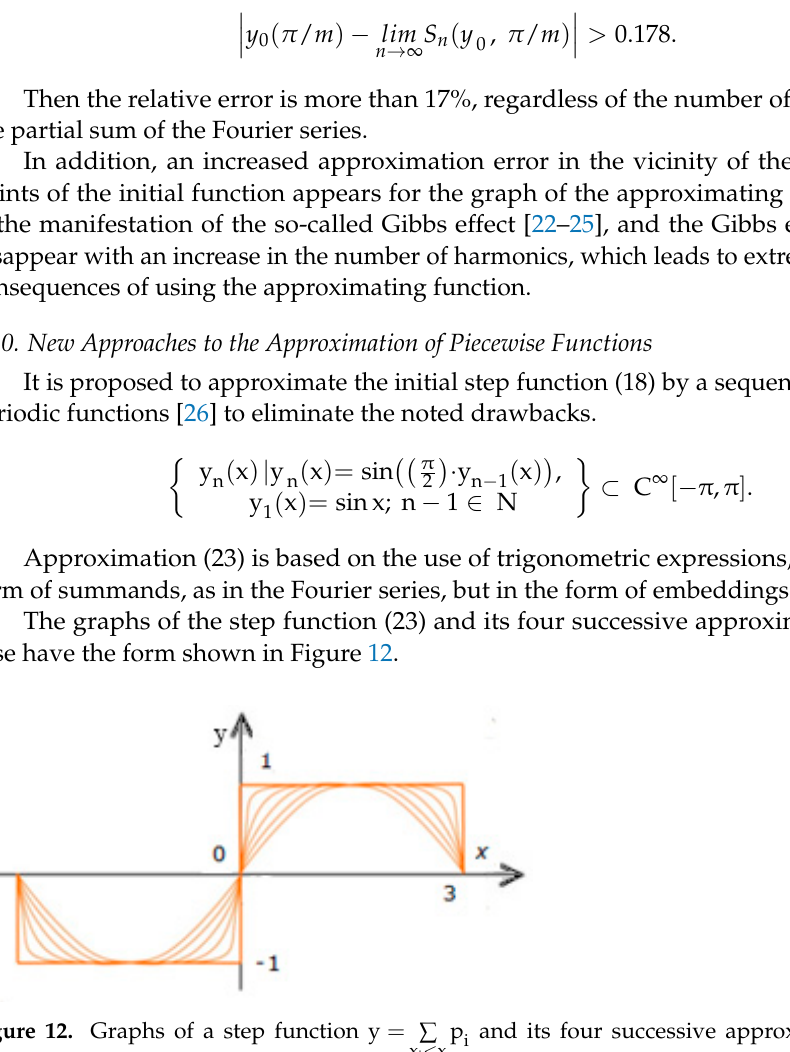
p and its four successive approximations using and its four successive approximations using i i <x x i < x